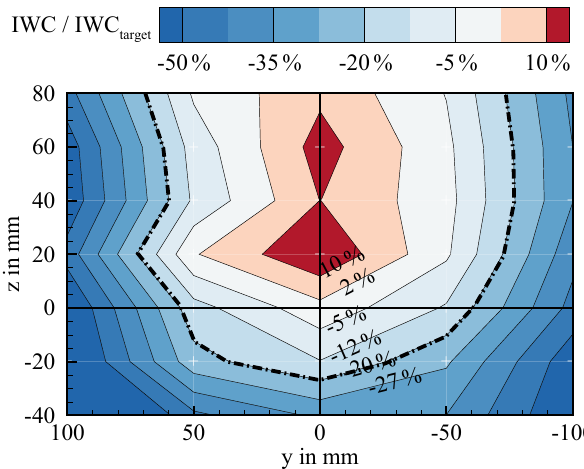
Figure 25. Percentaged deviation of IWC from centerline value, U ∞ = 40ms − 1 and f dosing = 20Hz.